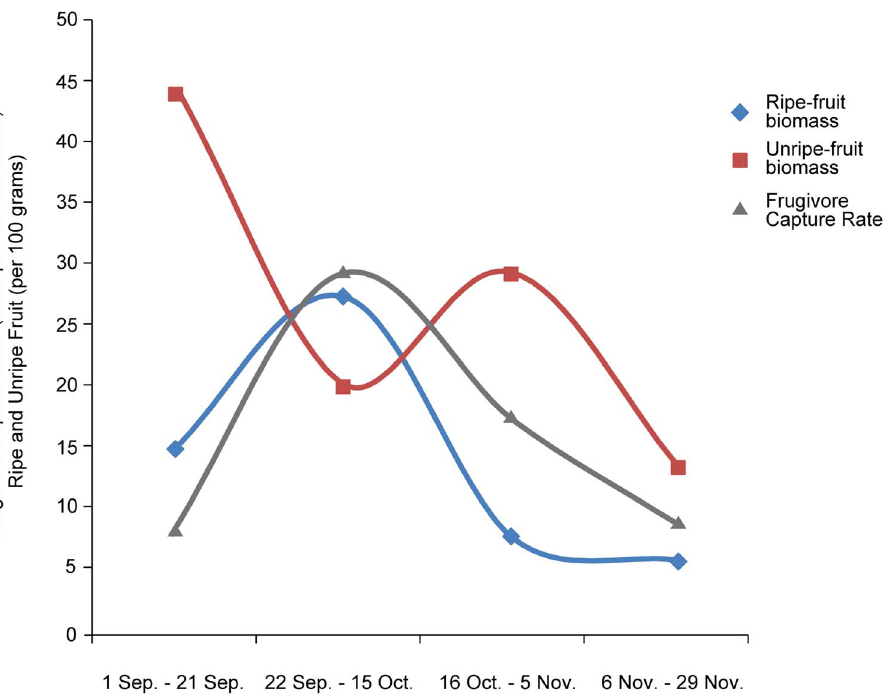
Figure 1. Frugivore capture rate (all study species except Northern Waterthrush, Eastern Wood-Pewee, Mourning Warbler, Canada Warbler) averaged across all net sites for each of the four sampling periods and associated summed seedless-ripe fruit biomass, across all vegetation plots for each of the four sampling periods in Tortuguero, Costa Rica, 2008.